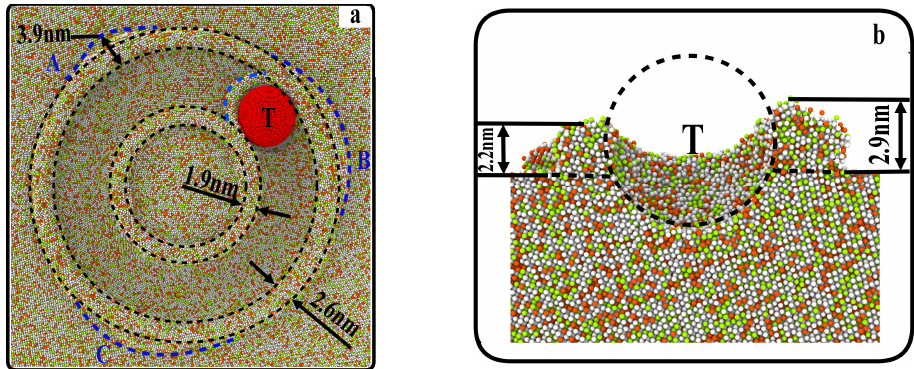
Figure 5. Debris accumulation morphology: ( a ) is the accumulation morphology diagram of debris atoms on the friction interface, and ( b ) is the height diagram of debris atoms inside and outside the abrasive particles .